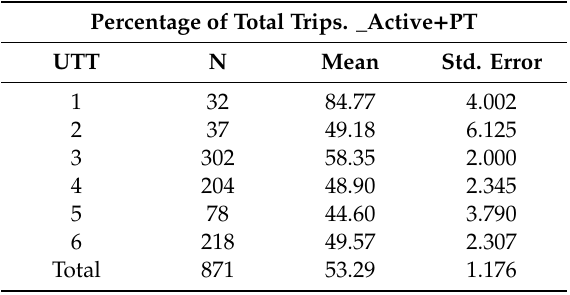
Table A2. Mean of the Proportion of Total Non-Work Trips using Sustainable Transport Modes (Active and Public transport) in each